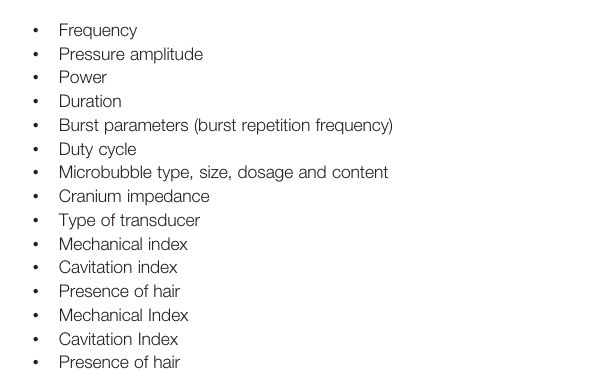
BOX 4 | Factors in fl uencing BBB/BTB disruption.